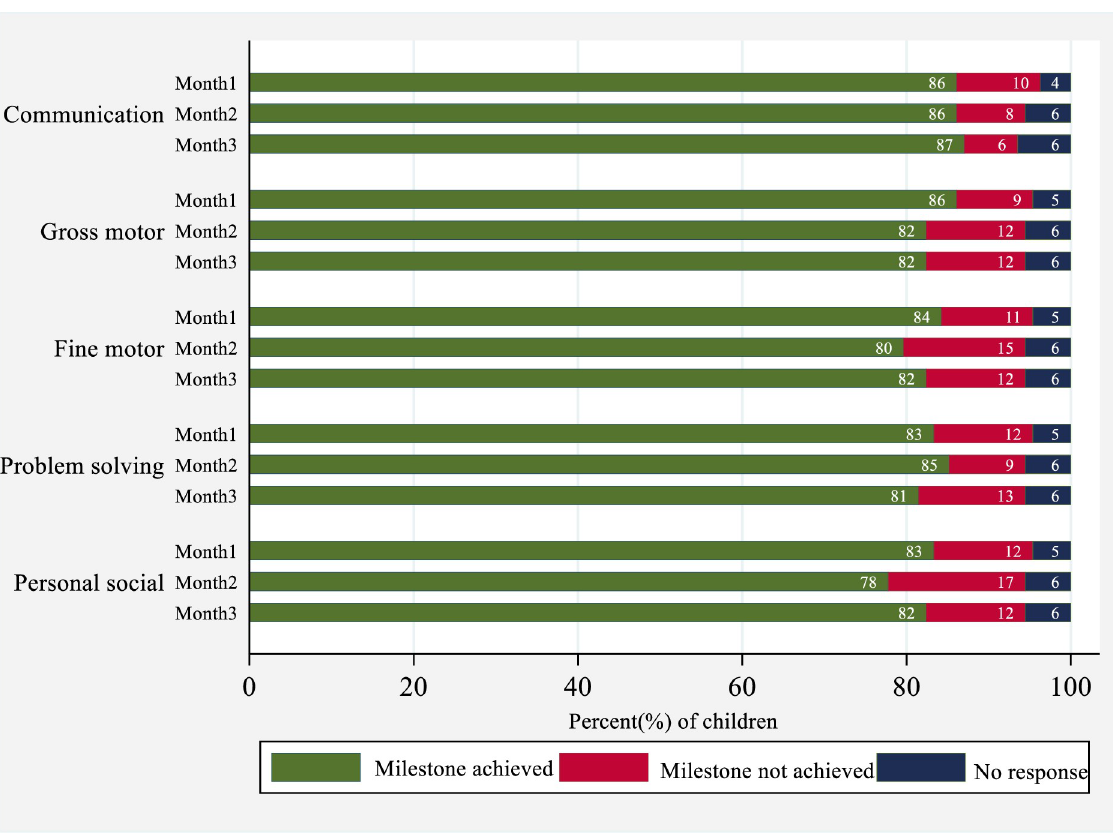
Fig 3. Caregiver report of achievement of developmental milestones by domain across the first three months of intervention.